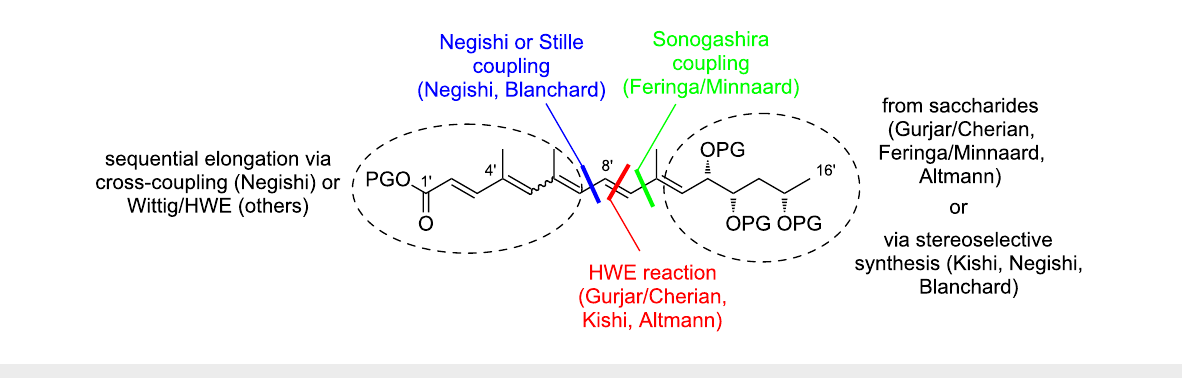
Figure 8: Synthetic strategies towards the mycolactone A/B lower side